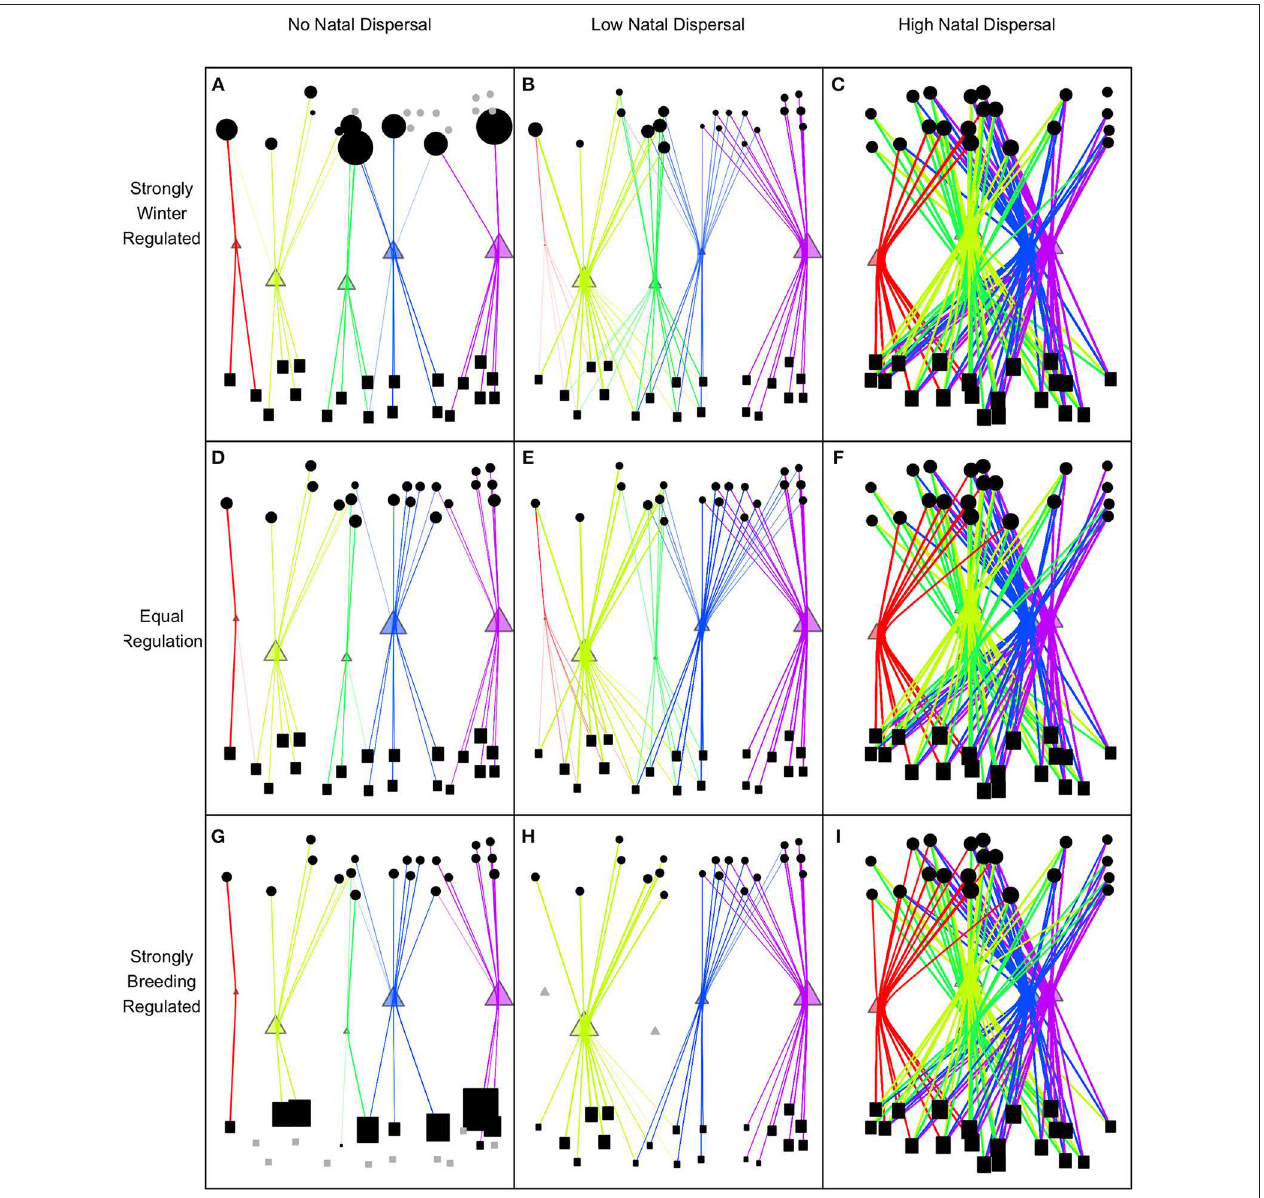
FIGURE 1 | Equilibrium connectivity of network with randomly generated locations of breeding (circles), winter (rectangles), and route (triangles) nodes when there is no natal dispersal ( ND = 0; A,D,G ), low natal dispersal ( ND = 0.05; B,E,H ), or high natal dispersal ( ND = 0.5; C,F,I ), and when the network is strongly regulated by availability of habitat in winter (reg = 0.17; A,B,C ), equally regulated by winter and breeding habitat (reg = 0.5; D,E,F ), or strongly regulated by breeding habitat (reg = 0.83; G,H,I ). The gray circles, triangles, and squares (e.g., in A,H,G ) are unoccupied breeding, route, and winter nodes, respectively. The relative size of each node is proportional to the size of the node population to show the distribution of the population within each